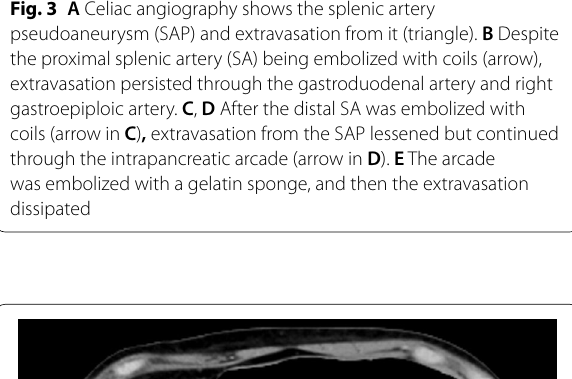
Fig. 3 A Celiac angiography shows the splenic artery pseudoaneurysm (SAP) and extravasation from it (triangle). B Despite the proximal splenic artery (SA) being embolized with coils (arrow), extravasation persisted through the gastroduodenal artery and right gastroepiploic artery. C , D After the distal SA was embolized with coils (arrow in C ) , extravasation from the SAP lessened but continued through the intrapancreatic arcade (arrow in D ). E The arcade was embolized with a gelatin sponge, and then the extravasation